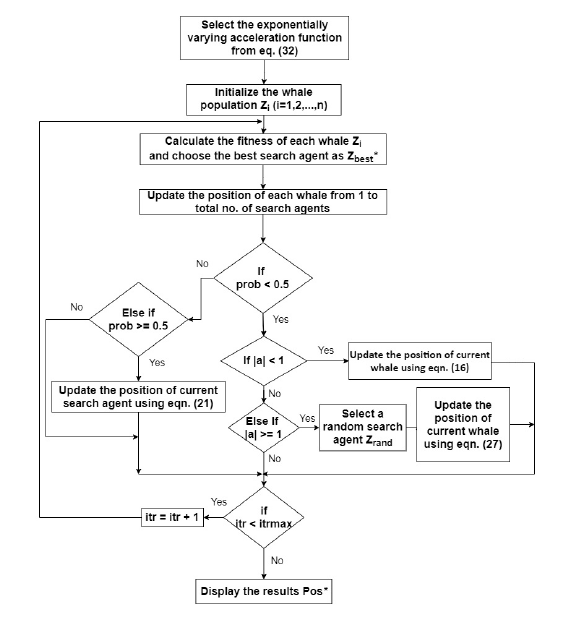
Figure 6. Flowchart of Exponentially Varying Whale Optimization Algorithm